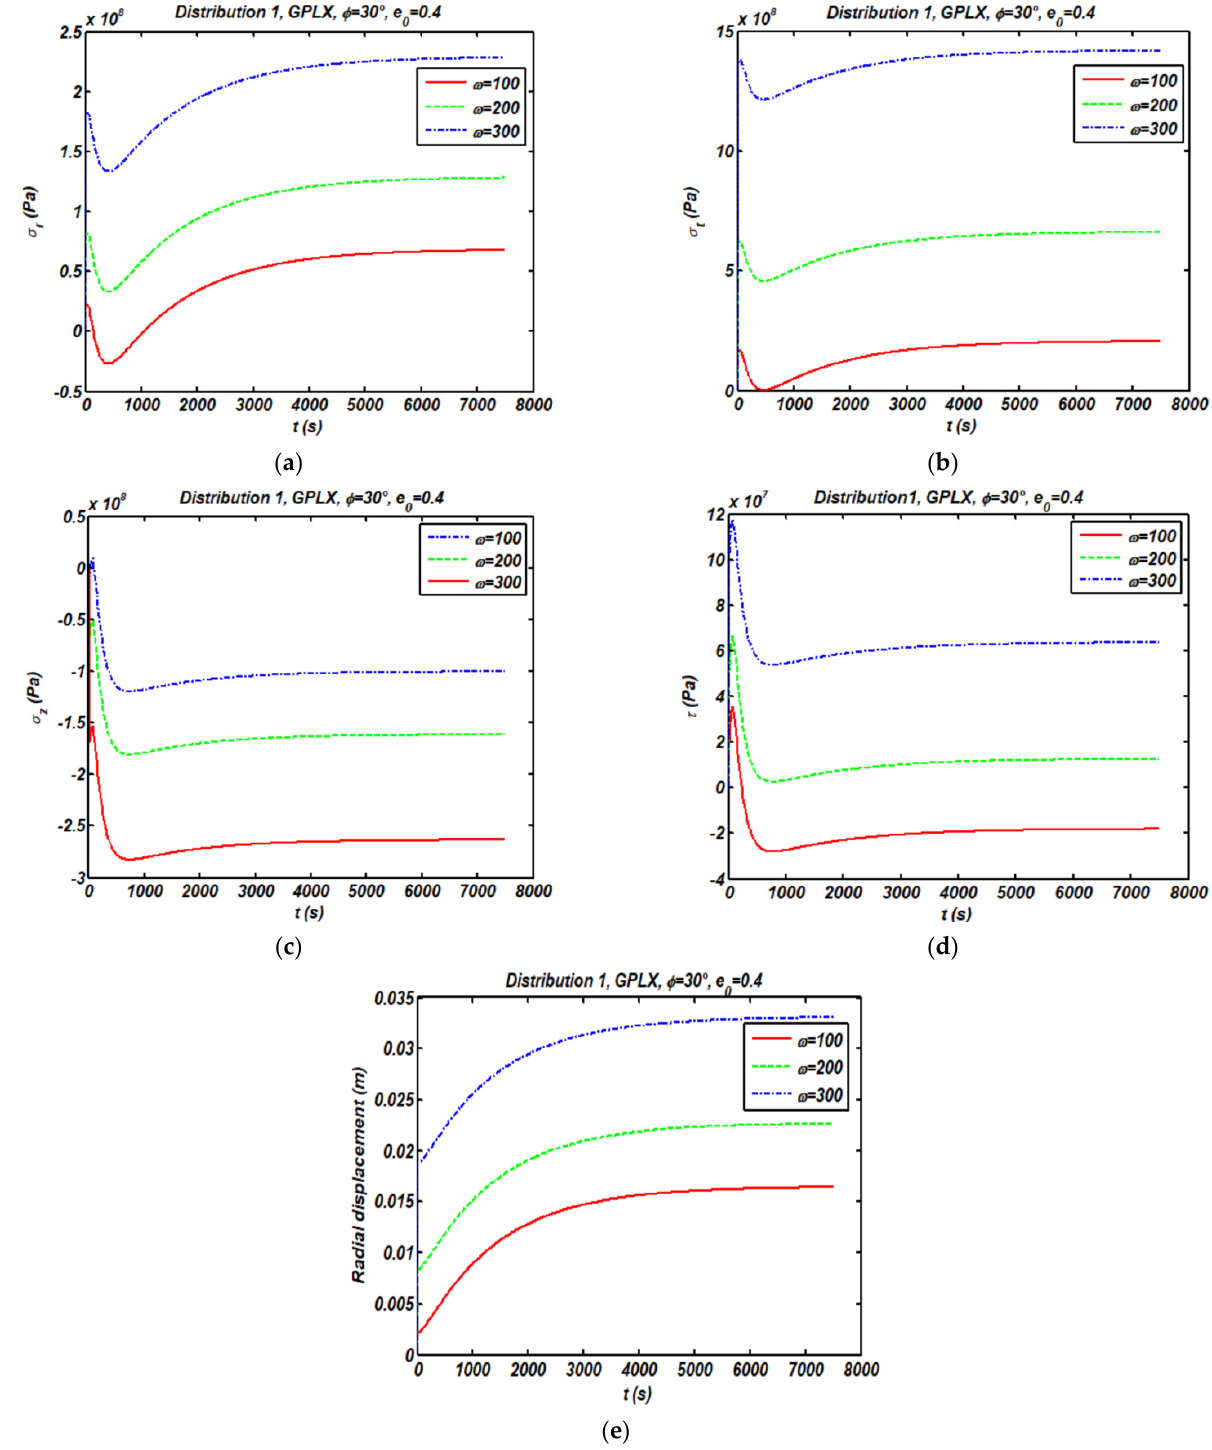
Figure 8. Influence of the circular velocity on the transient stress state ( a – d ) and radial displacement ( e ) for a center point of truncated cone (D1-GPL X; e 0 = 0.4; φ = 30 ◦ ; γ GPL =